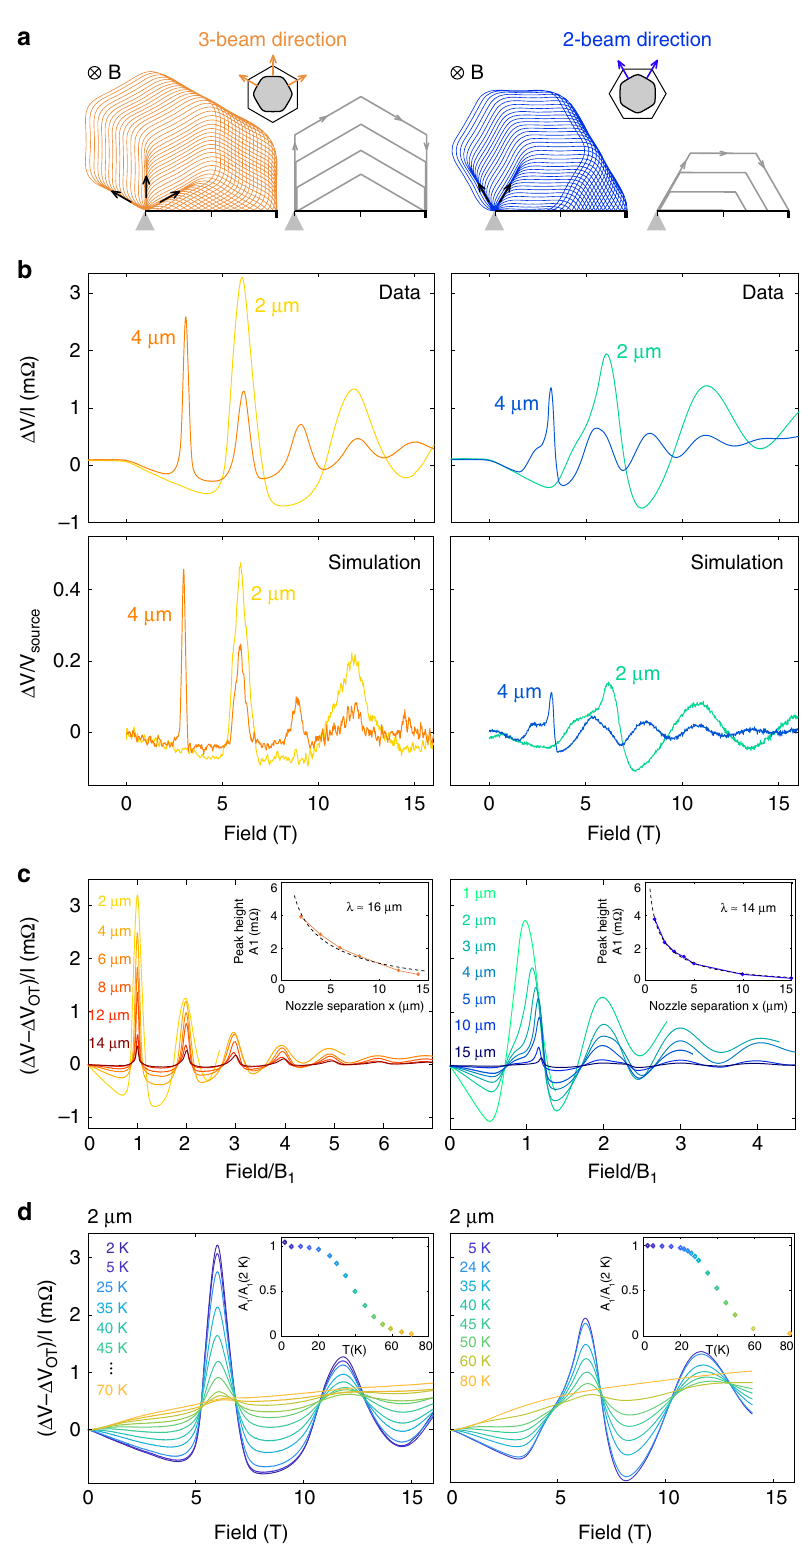
directions, as seen in Fig. 3b. At negative fi elds, there is a small, diffusive magnetoresistive component. Since there is only one type of charge carrier (electrons) present in this system, no focusing peaks are observed at negative fi elds. At small positive fi elds, where the cyclotron diameter is larger than the separation of the nozzles, a voltage inversion is observed: more electrons reach the large